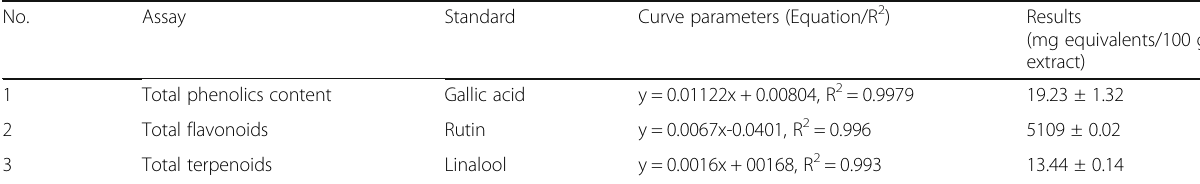
Table 2 Results and calibration curves parameters of the phytochemical assays No.